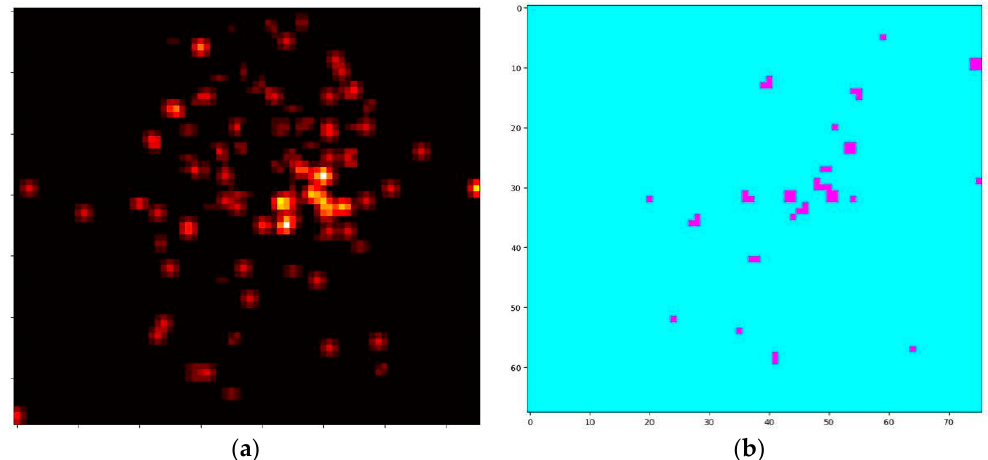
Figure 14. ( a ) The heat map of the POIs. It intends to reflect a combined relevance of the POIs of the type of Starbucks and cinema. Brighter grids denote a higher value of their combined relevance, i.e. both are densely distributed in this ROI, while the dark ones are the opposite. It is worth noting that the grids populated by only one type of POI do not show a very high correlation. ( b ) The top-50 query results by RALL. The top-50 query results are basically consistent with the brighter grids in ( a ), reflecting that our method can achieve good performance in the task of multi-keyword queries.